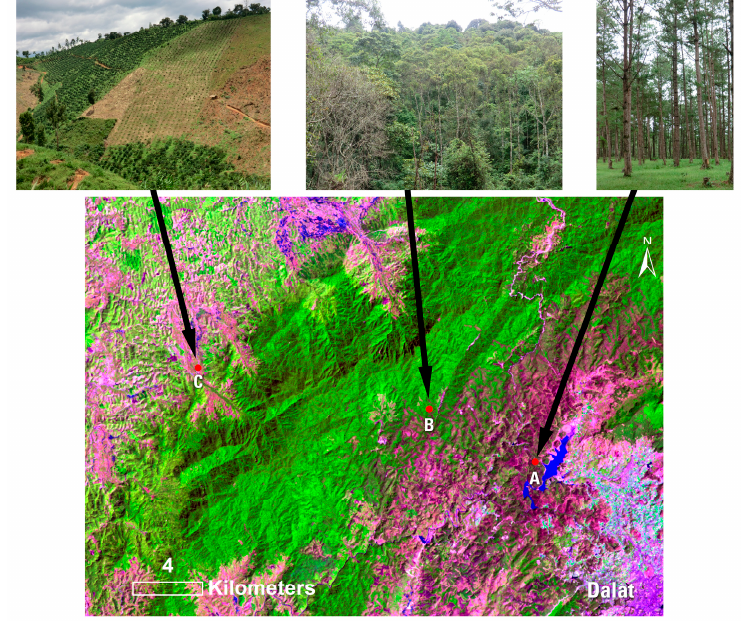
Figure 3. Field photos showing several representative land cover types in study area, and their location on Landsat imagery. A = Conifer (pine) forest; B = Mature broadleaf forest; C = Coffee plantation.